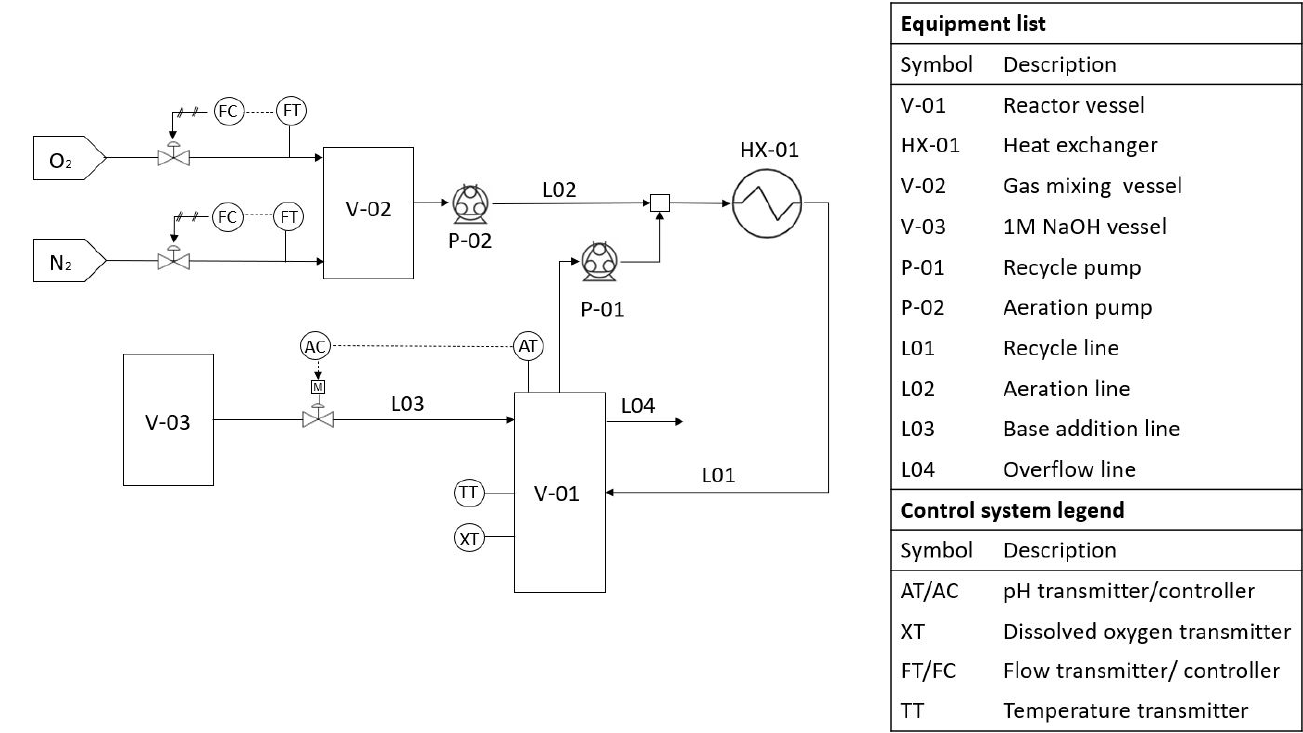
Figure 1. Diagram of the laboratory-scale reactor